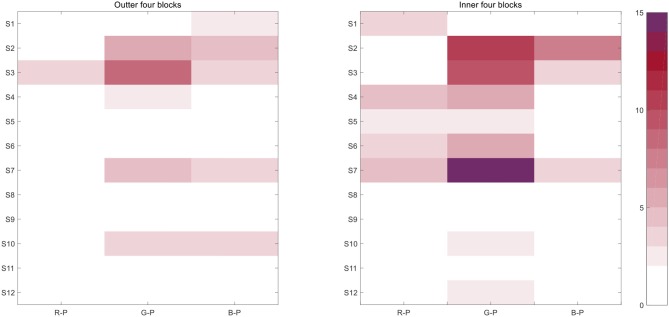
The error trials contributed by outer and inner blocks. Note: the number implies the error trials happened for one subject in one paradigm and the overall sum of trials was 240 (16 targets × 15 times); the statistical results in this section were all corrected by Bonferroni correction.